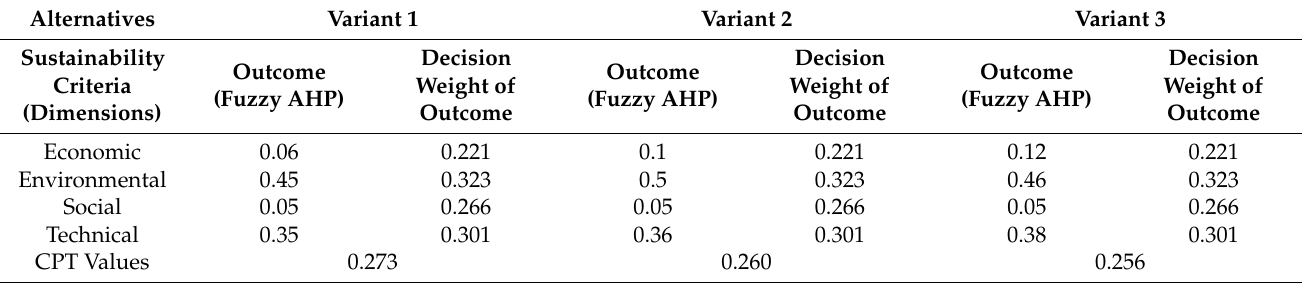
Table 10. Recalculation of the CPT values for the energy technology variants; decision weights were calculated using http://psych.fullerton.edu/mbirnbaum/calculators/cpt_calculator.htm (accessed on 25 October